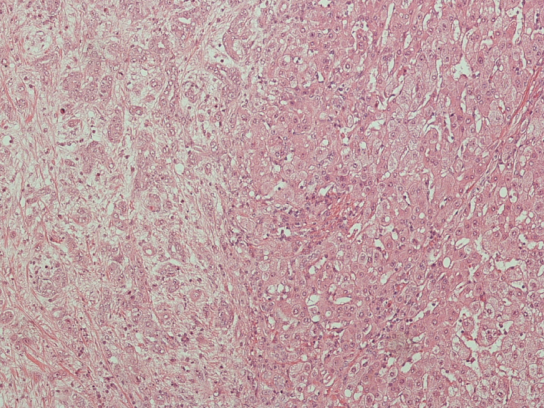
Figure 4. Histological features of combined hepatocellular cholangiocarcinoma (hematoxylin and eosin staining). Passage area between cholangiocarcinoma features ( left ) and HCC component ( right